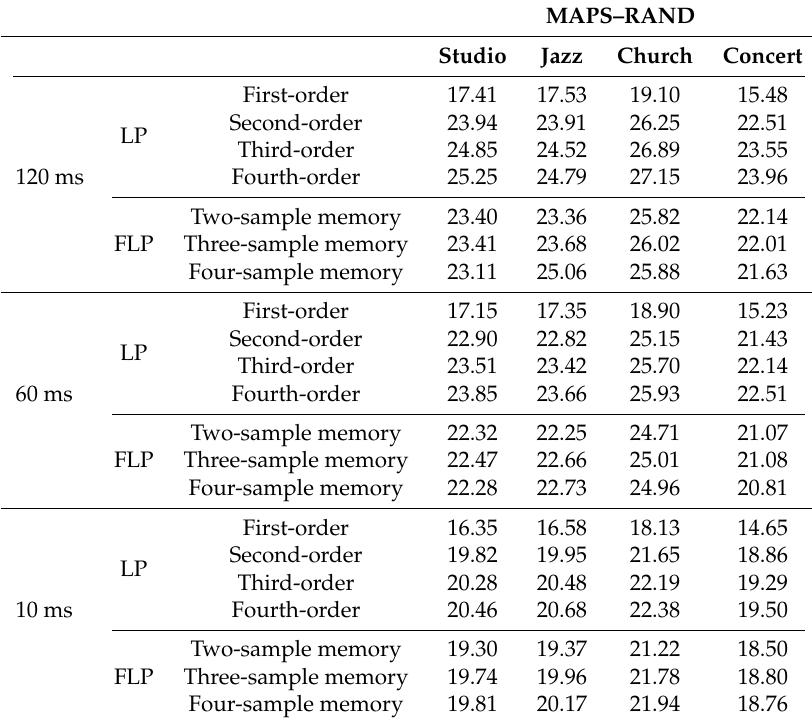
Table 1. Prediction gain (dB) for the chords composed of three randomly chosen notes (MAPS–RAND subset).